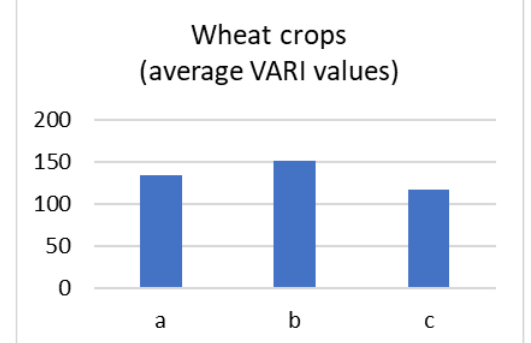
Figure 8- chart of VARI for wheat crops; a- wheat germinating, b-wheat flowering, c-wheat